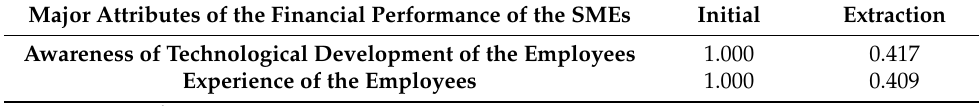
Table 21. Extraction